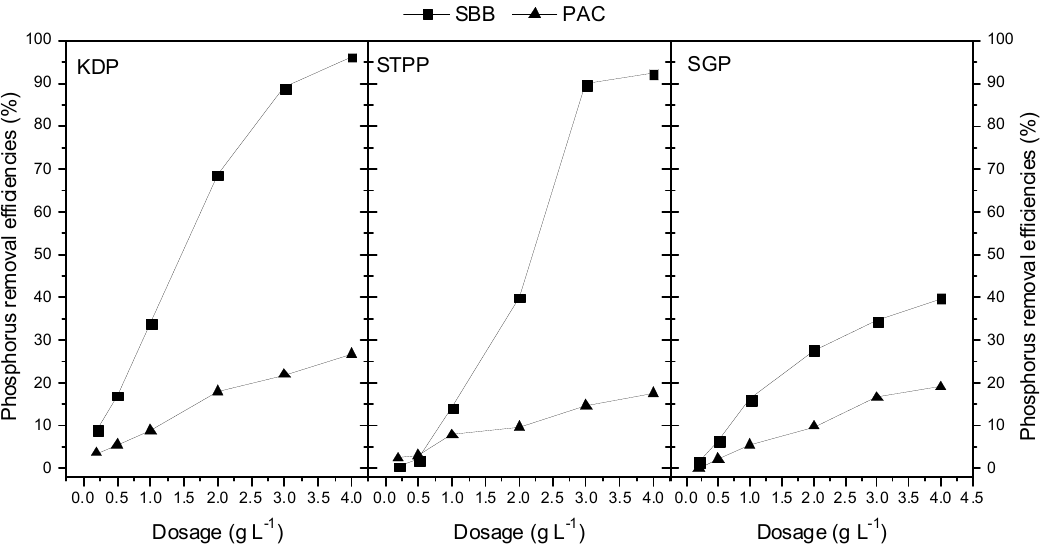
Figure 3. Effect of adsorbent dosage on the removal of phosphates on SBB and PAC (Phosphate concentration: 20 mg · L − 1 ; contact time: 2 h (KDP), 1 h (STPP), 0.5 h (SGP); shaking rate: 120 r.p.m.). Table 3. Constants in the Langmuir and Freundlich isotherms for the adsorption of KDP, STPP and SGP on SBB or